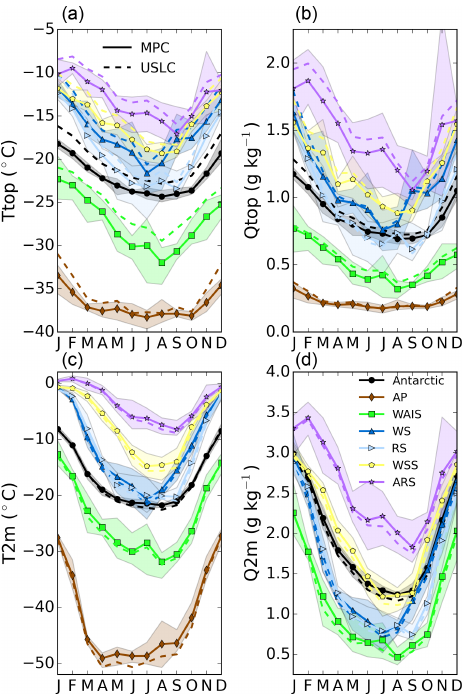
Figure 11. (a–b) Monthly time series of the in-cloud temperature (Ttop) (a) , and of the in-cloud water vapour mixing ratio (Qtop) (b) , at the top of the low-level MPC and USLC layers, for the different regions of interest. (c–d) Monthly time series of near-surface (2m) temperature (c) and the water vapour mass mixing ratio (d) below these layers. The shaded areas indicate the interannual variability for the MPC layers. For readability, the ones for the USLC layers are not shown, but they are of similar amplitude.